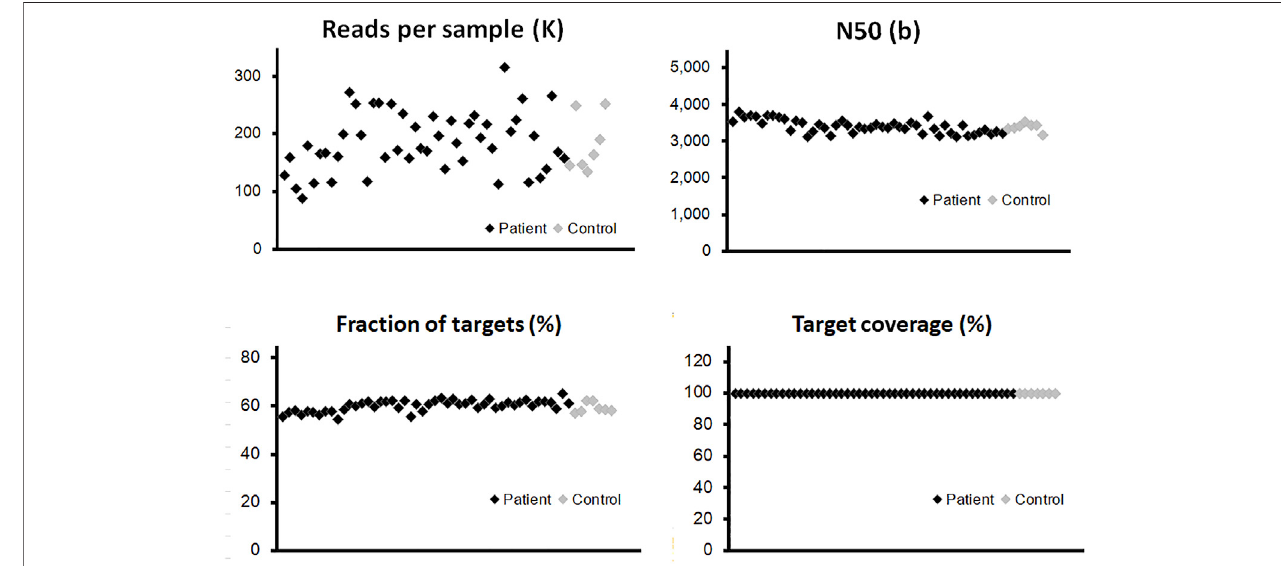
FIGURE 2 | Quality control of long-read sequencing for the panel of 28 genes. The probes were designed to cover the whole genome regions of all panel genes, which are around 5M-base coverage of detection. The vertical axis of each point illustrated the quantitative information from individual blood sample, para-tumor tissue, or tumor tissue. The effective read numbers were around 100 – 300 kb per sample, and the N50s were around 3,000 – 4,000. No obvious differences could be detected between patient and control groups (black and gray points, respectively). After the alignment process, the fraction of targets among different samples was around 55% with a slightly fl uctuation. The coverage of the target region was above 99% in all tested